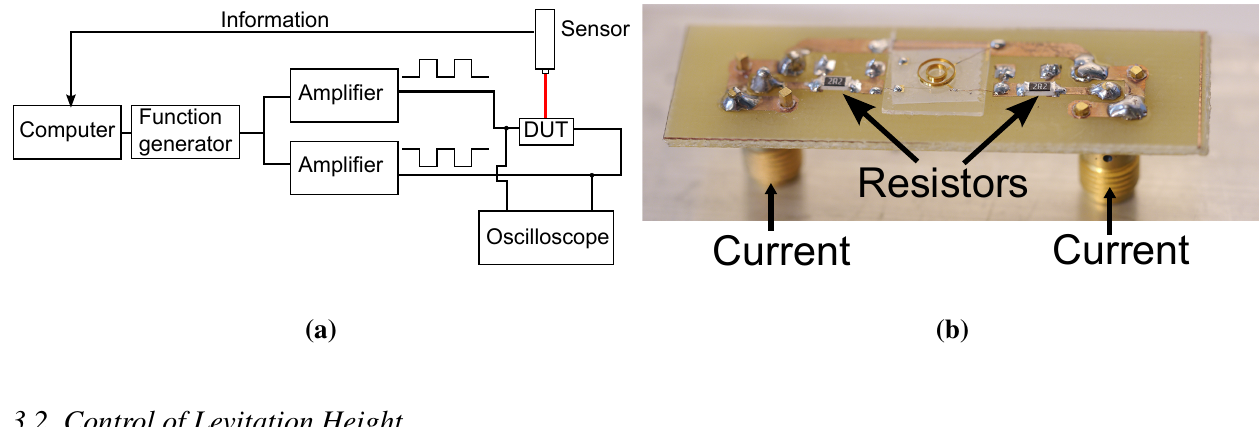
Figure 3. ( a ) Schematic of the experiment setup and ( b ) photo of a 3D MIS on a printed circuit